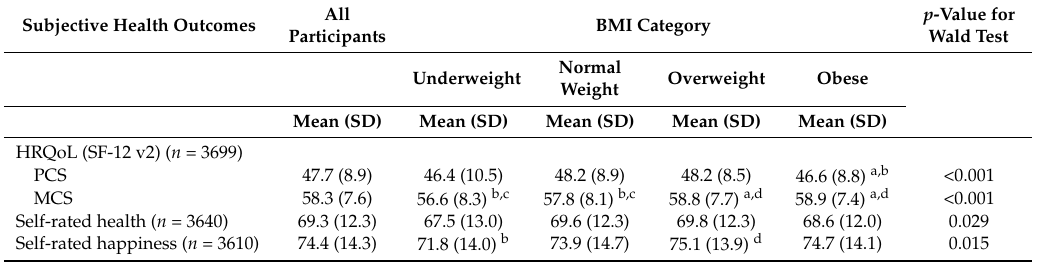
Table 3. Scores of Health-related Quality of Life (HRQoL), Self-rated Health and Self-rated Happiness by Body Mass Index